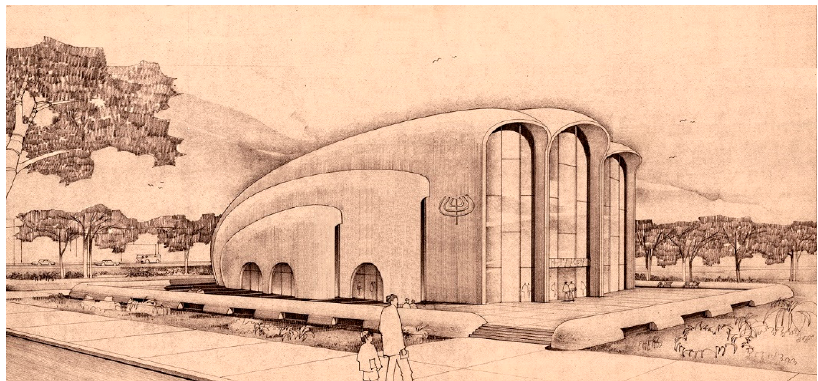
Figure 10. Heichal Yehuda Synagogue, Tel Aviv. Yitzhak Toledano (architect), Aharon Rousso (structural engineer), 1980. Perspective. Architect Norberto Kahan, early 1970’s. Used with